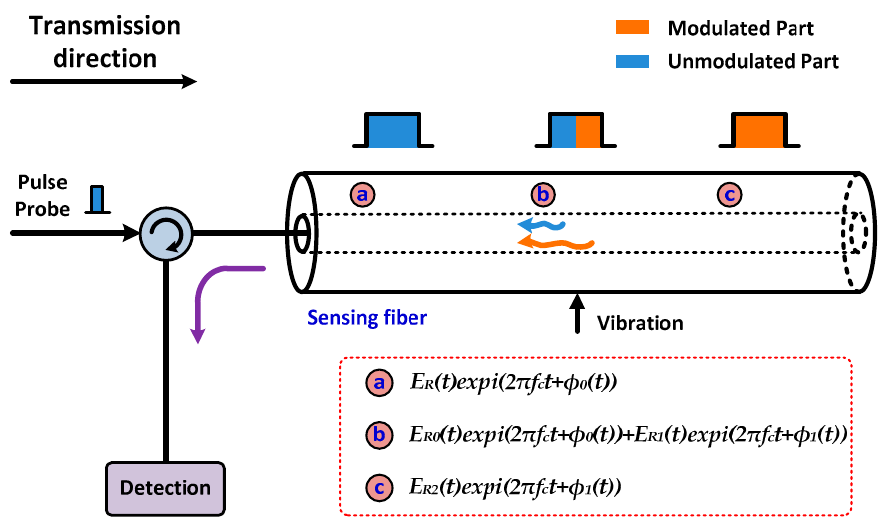
Figure 1. The theory description of the phase-sensitive OTDR.